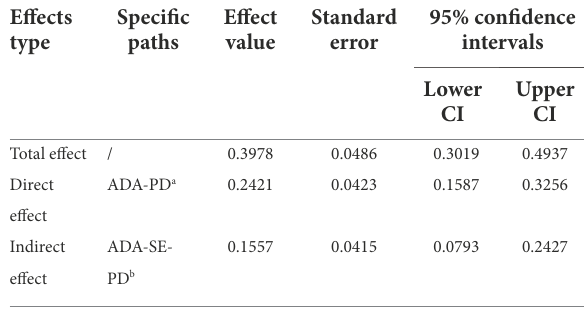
TABLE 2 Mediating effects of self-efficacy ( N = 170).